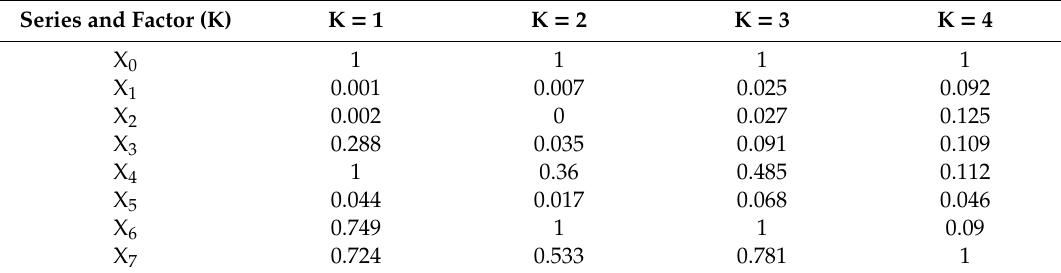
Table A2. Standardization of the